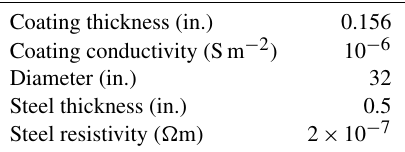
Table 3. GASBOL technical information.